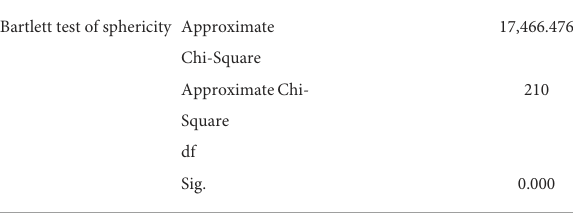
TABLE 5 KMO and Bartlett test.